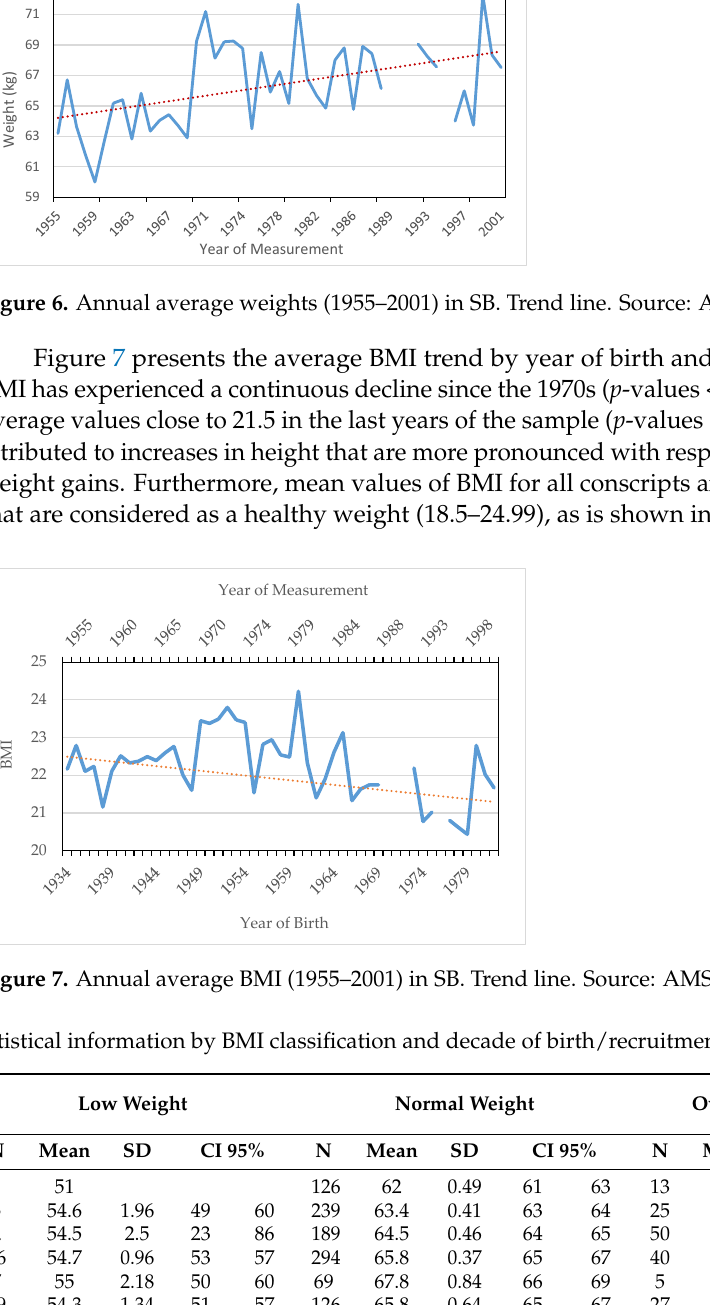
Table 3. Statistical information by BMI classification and decade of